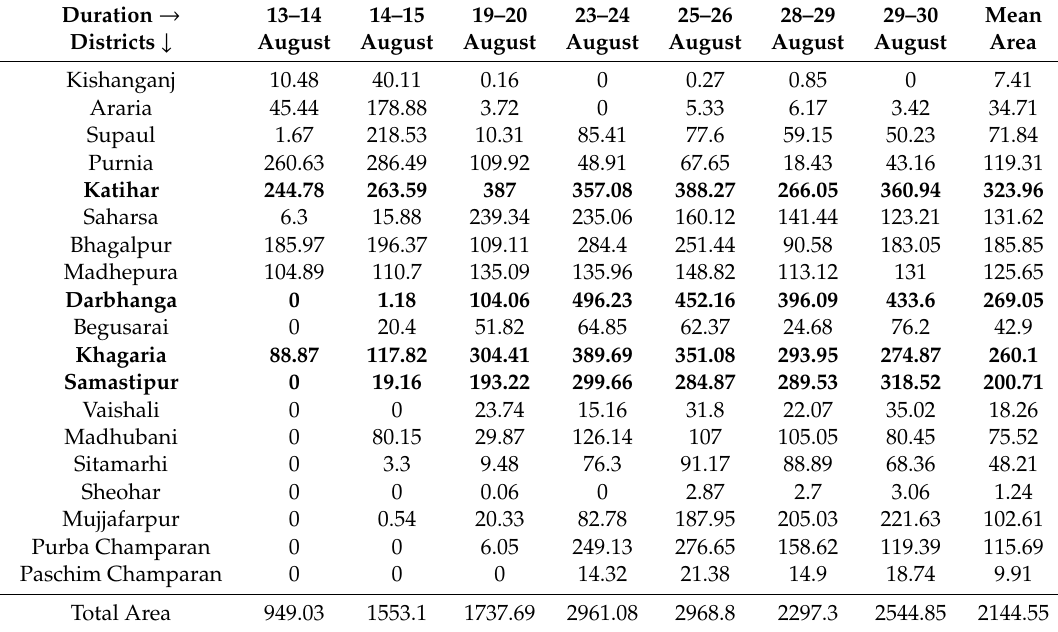
Table 4. District wise inundation extent (sq.km.) for the period of 13–30th August 2017. The bold indicates major